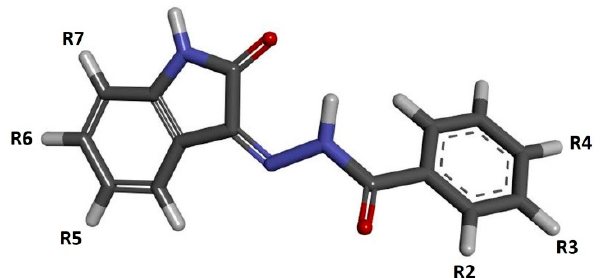
Figure 1. The graphic representation of isatin derivatives. Symbols R2–R7 represent places of addition of new chemical residues modifying the chemical properties of the native compound.